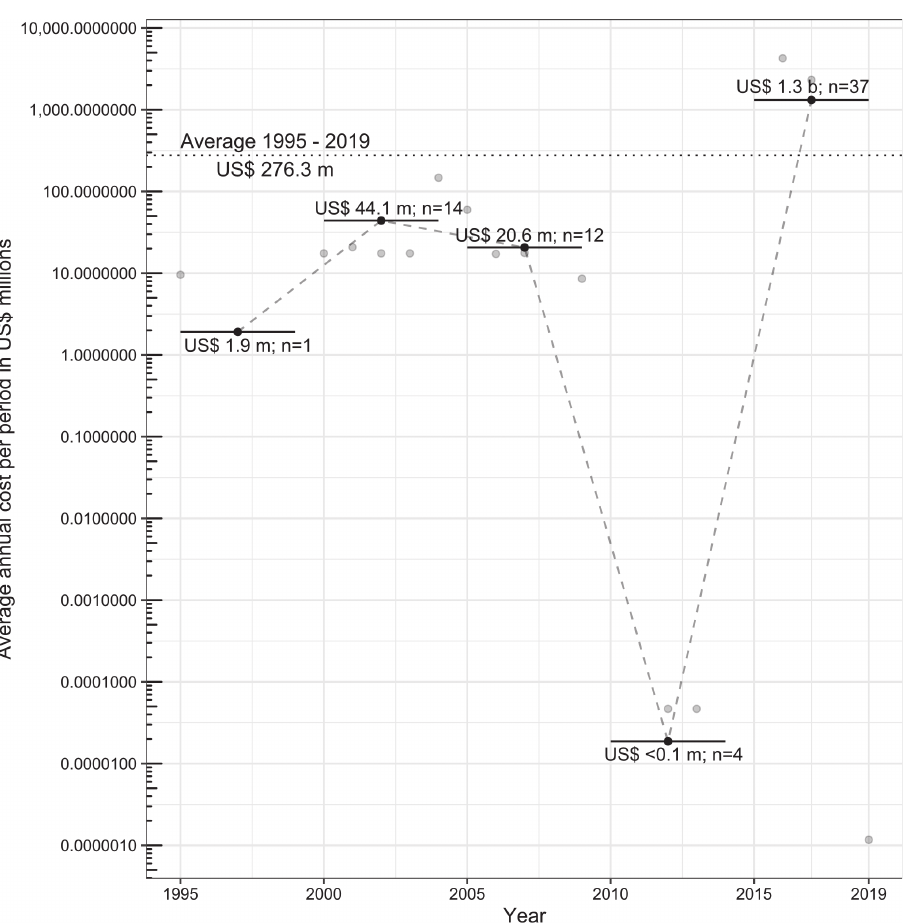
Figure 1. Cumulative economic costs of IAS in Argentina over time. Costs expanded between 1995 and 2019. Points are total annual costs for every year (i.e., all individual costs for a specific year are summed). Lines represent the average annual cost for 5 year intervals and the “n” in each line indicates the number of records in each